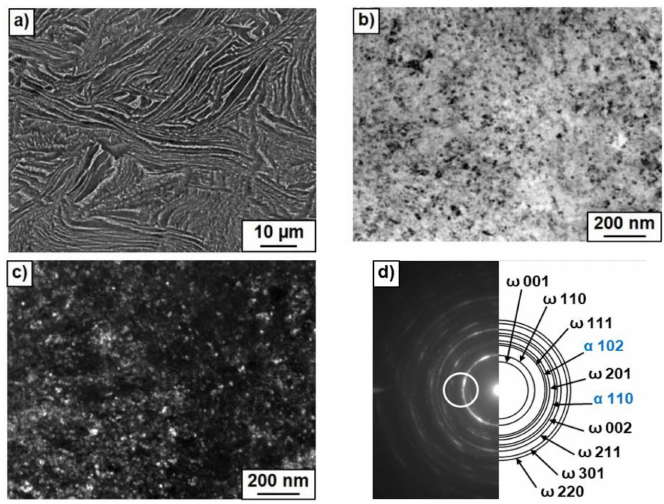
Figure 3. Microstructure of Ti–4 wt.% Co alloy after annealing at 400 ◦ C and high pressure torsion (HPT). ( a ) Scanning electron microscopy (SEM) micrograph. ( b ) Bright field and ( c ) dark field transmission electron microscopy (TEM) micrographs after annealing at 400 ◦ C and following HPT. ( d ) Selected area electron diffraction pattern.